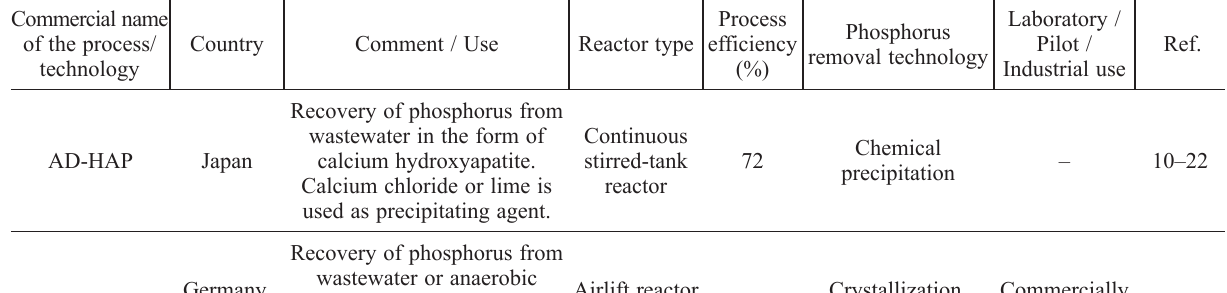
Table 1 – Commercial technologies used for the recovery of phosphorus from waste